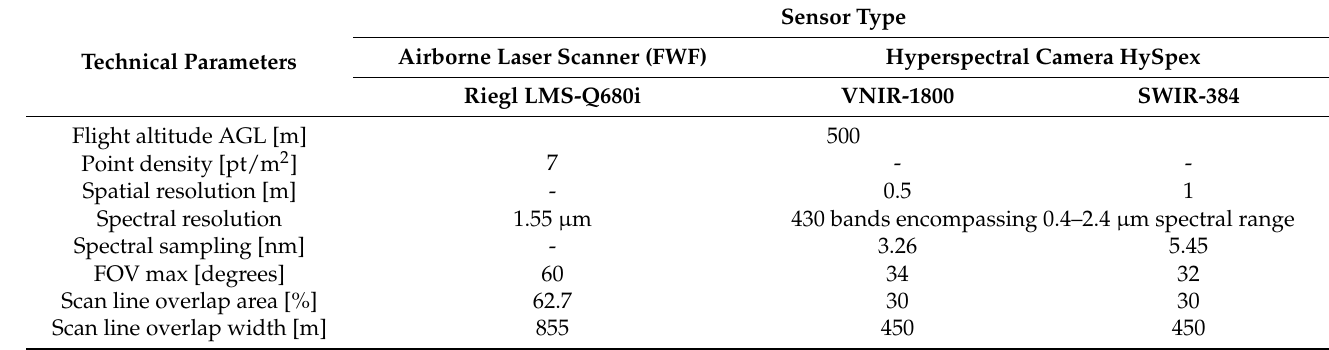
Table 2. Technical parameters of the sensors used, and the remote sensing data obtained using HabitARS